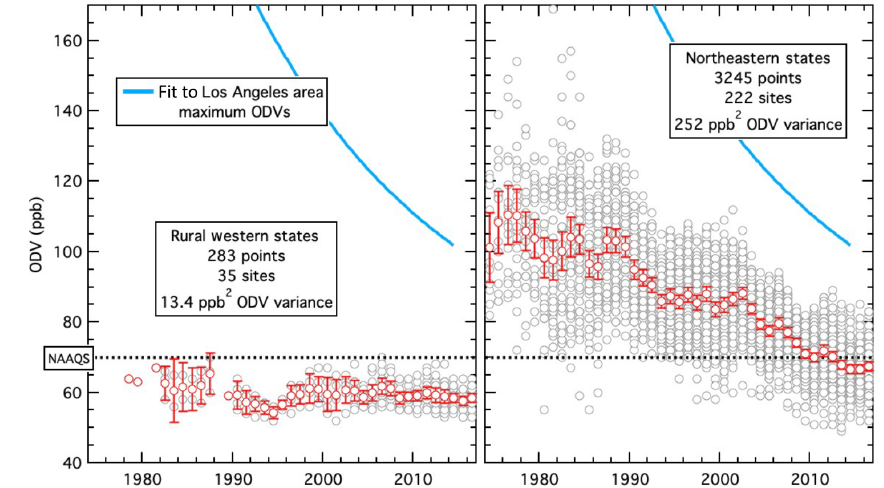
Figure 3. Time series of all ODVs (grey symbols) reported from all monitoring sites in the two northern US regions shown in Figs. 1 and 2. The numbers of monitoring sites and reported ODVs and the ODV variance are annotated for each region. The red symbols give the averages and 2 σ confidence limits for all ODVs reported in each year. For comparison, the blue curve in each panel indicates a fit to the maximum ODVs recorded in the Los Angeles urban area (Parrish et al., 2017a). The dotted line indicates the 2015 NAAQS of